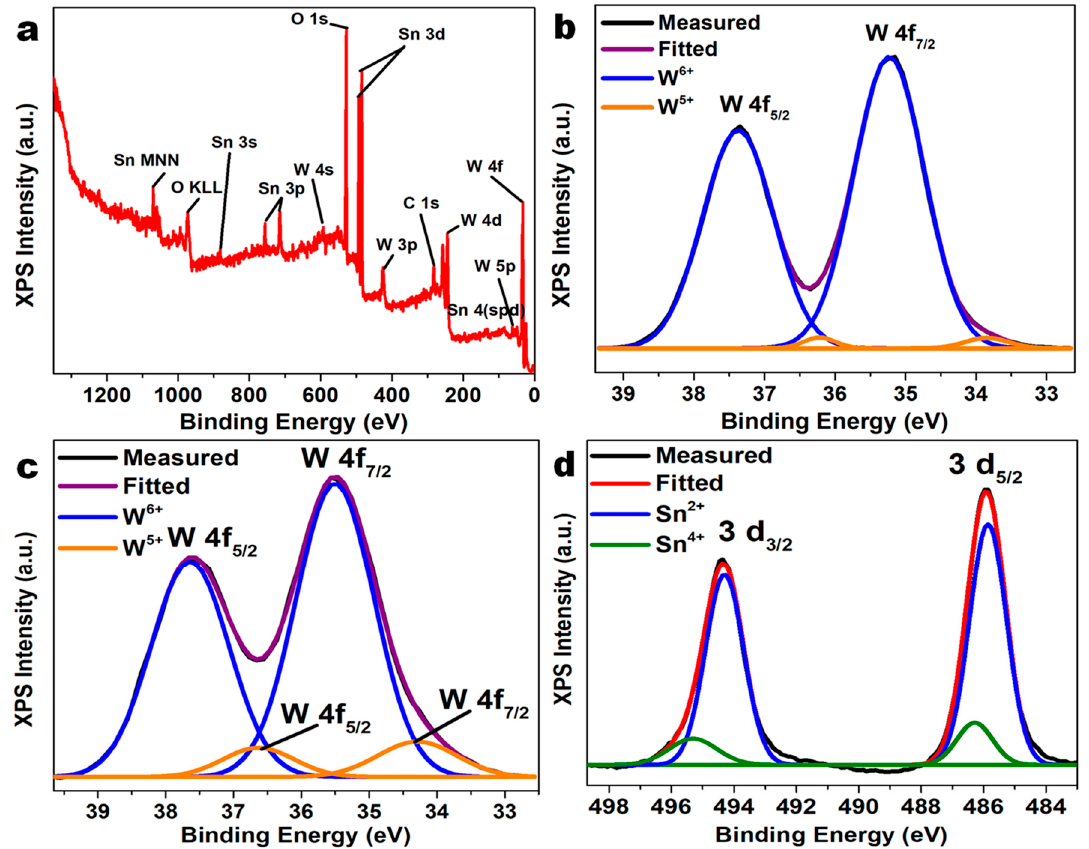
Figure 6. ( a ) XPS survey spectrum of the Sn-doped WO 3 thin film. Deconvoluted high-resolution XPS spectra of W 4f core level of ( b ) undoped and ( c ) Sn-doped WO 3 . ( d ) Deconvoluted high-resolution XPS spectra of Sn 3d core levels.